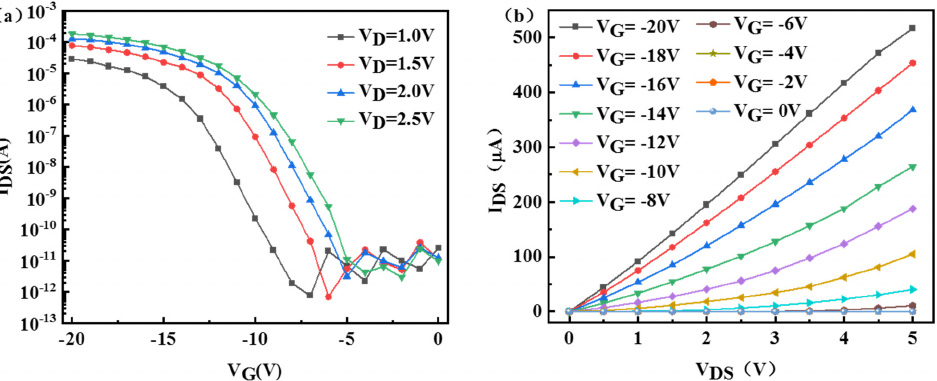
Figure 2. Electrical characteristic curve of SiNW − FET. ( a ) Transfer characteristic curve (I DS − V G ). ( b ) Output characteristic curve (I DS − V DS ).